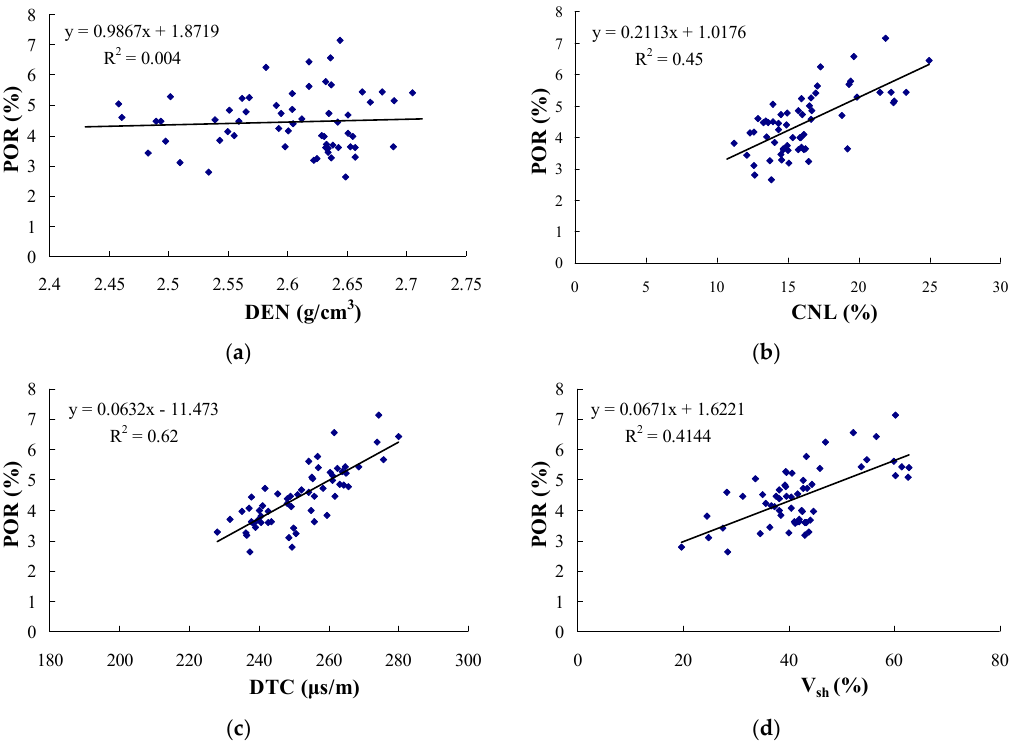
Figure 3. Relationship between the core porosity and logging parameters of the Longmaxi–Wufeng Formation shale in the Sichuan Basin: ( a ) correlation between the core porosity and the DEN; ( b ) correlation between the core porosity and the CNL; ( c ) correlation between the core porosity and the DTC; ( d ) correlation between the core porosity and the V sh .